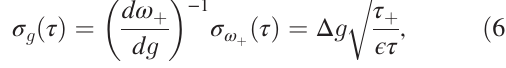
p ffiffiffiffiffiffiffiffiffiffi τ = τ þ